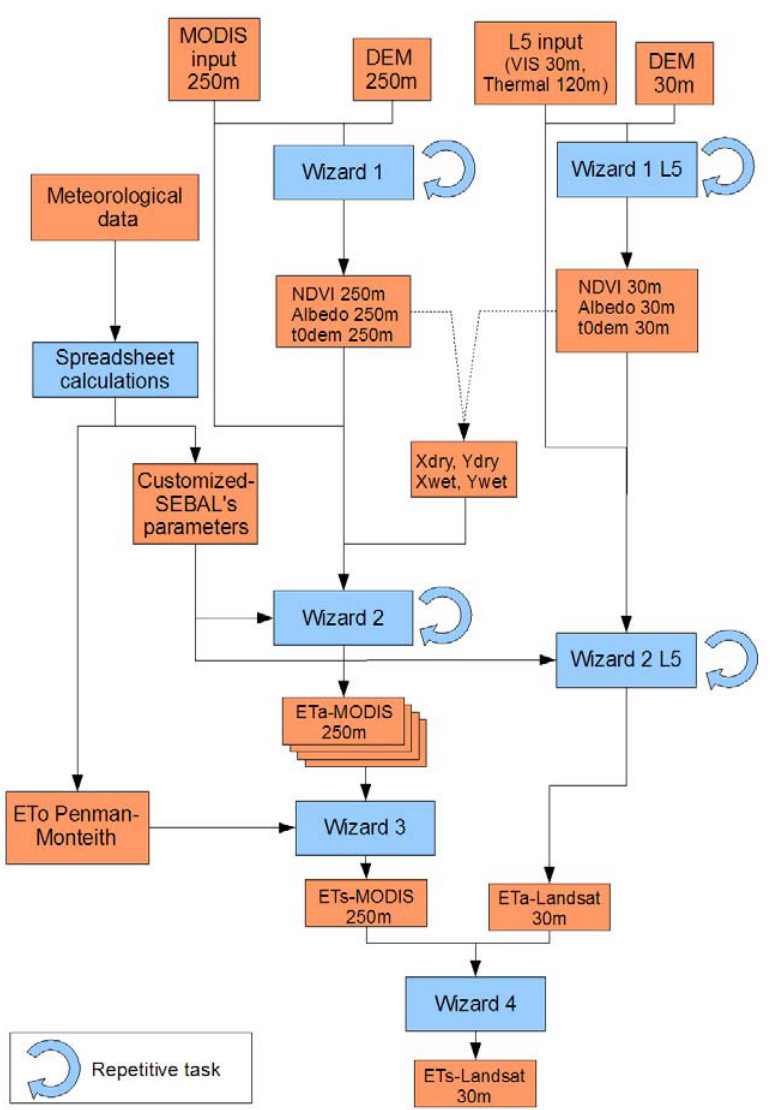
Figure 4. Operation scheme of the ITA-Water